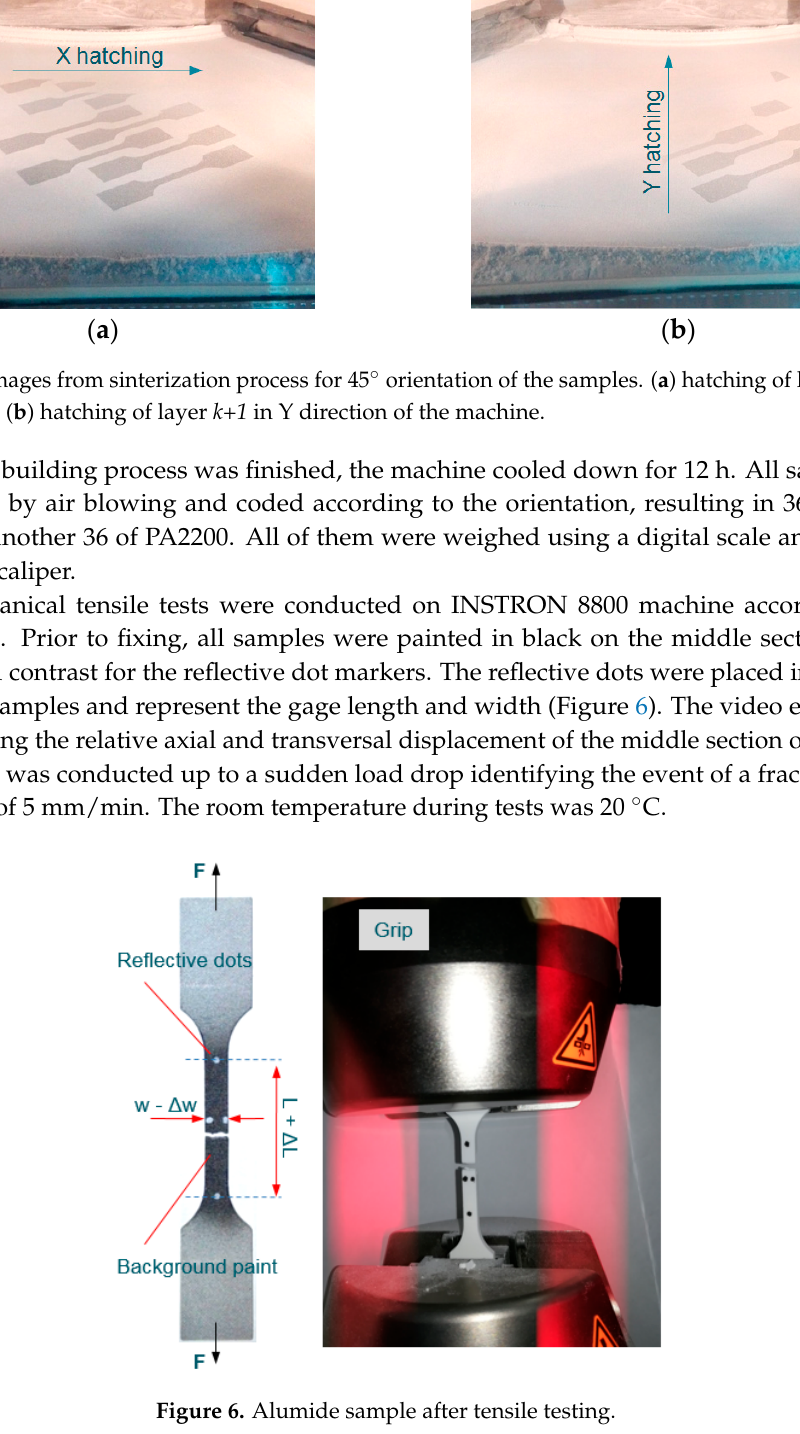
Figure 6. Alumide sample after tensile testing.